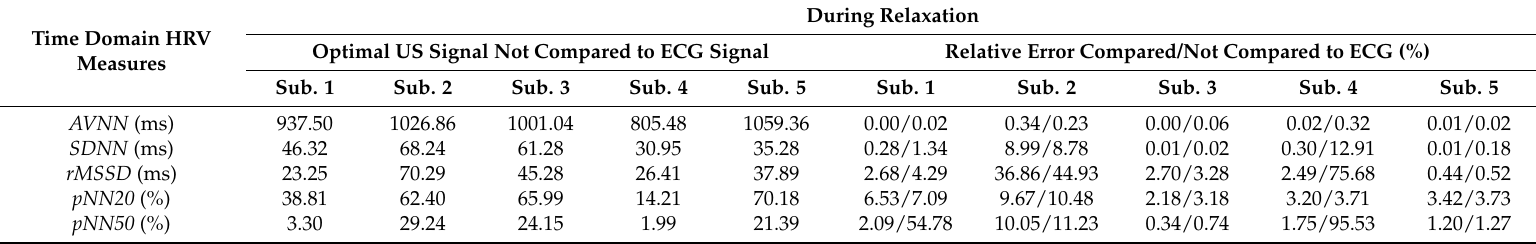
Table 4. Representative time domain values of HRV measurements in a 5 min data set, during relaxation, subject 1–5, part